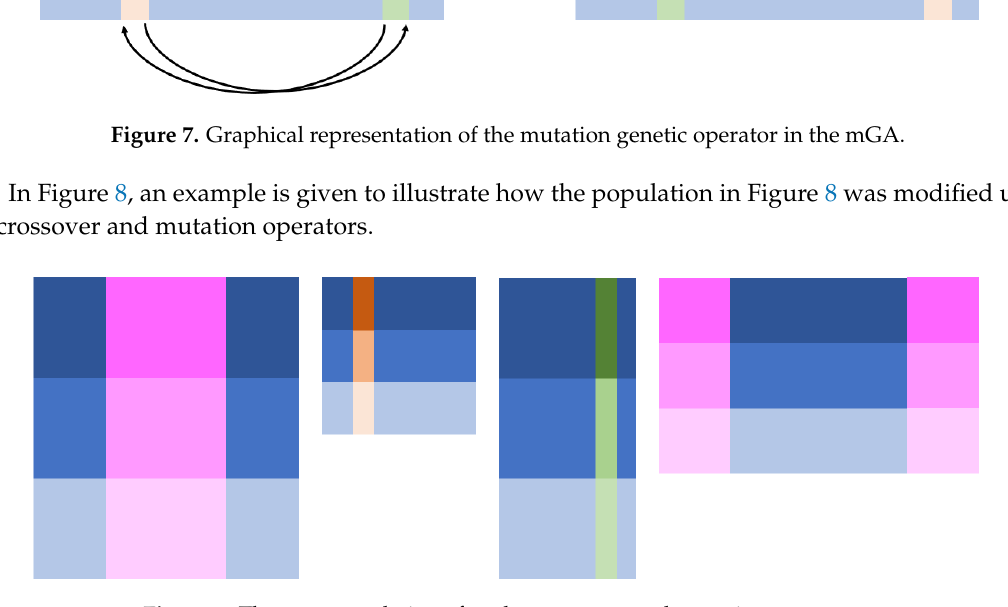
Figure 8. The new population after the crossover and mutation operators.